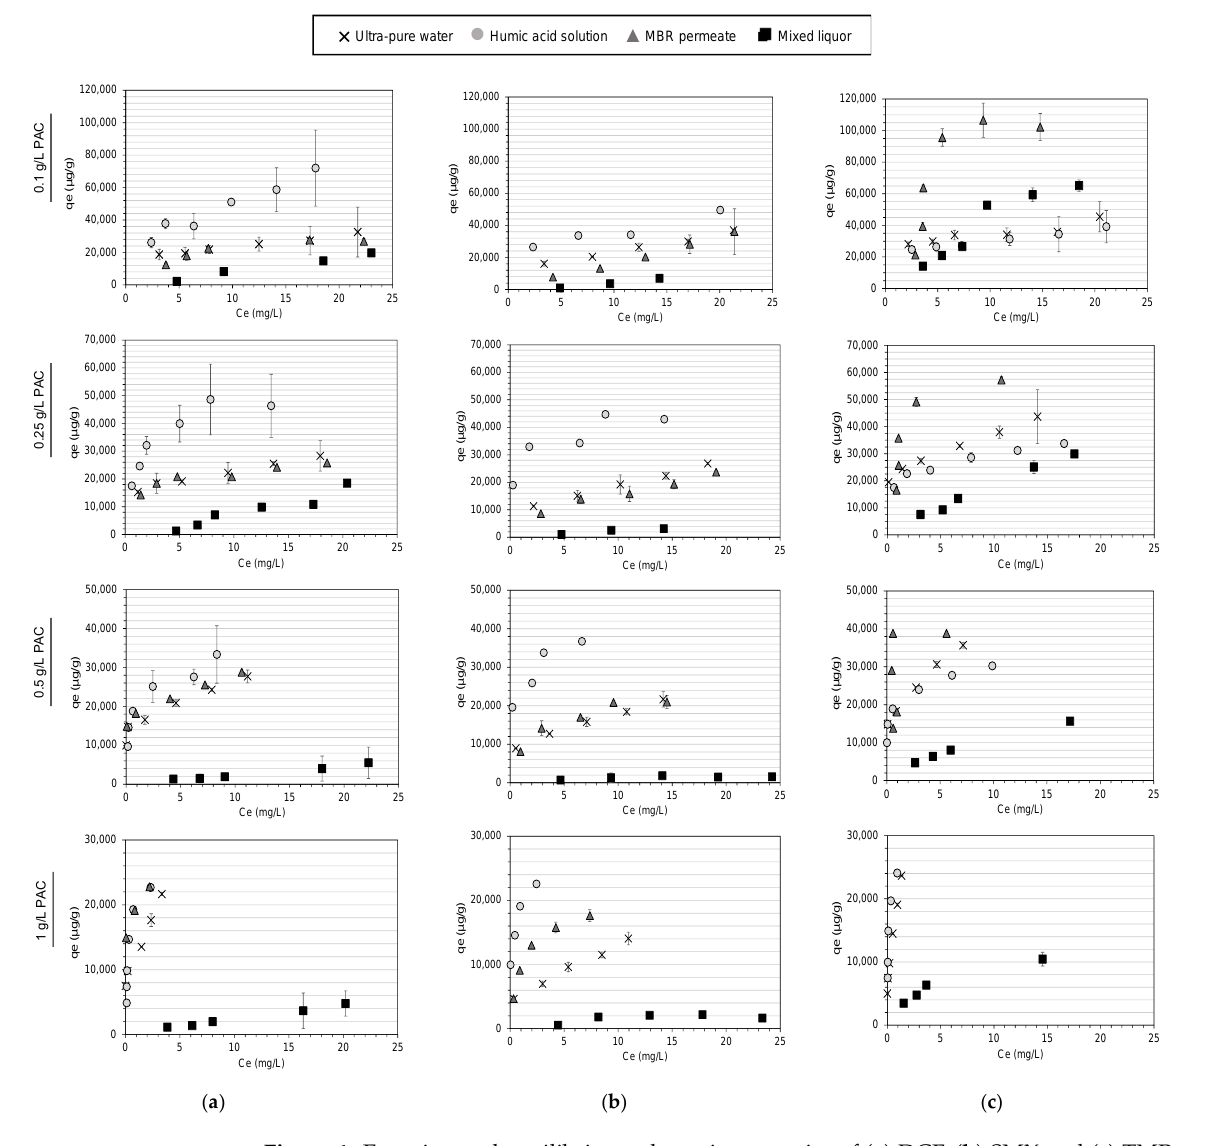
Figure 4. Experimental equilibrium adsorption capacity of ( a ) DCF, ( b ) SMX and ( c ) TMP at four different PAC concentrations (0.1, 0.25, 0.5 and 1 g/L) in ultra-pure water (×), humic acid solution ( ○ ), MBR permeate ( ▲) and mixed liquor from a WWTP ( ■) . Error bars indicate the standard deviation.